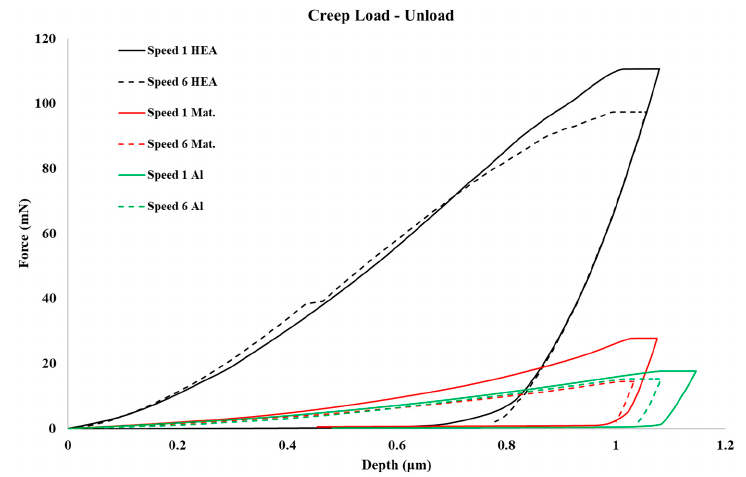
Figure 6. Creep indentation load—unload cycle curves for pure Al, matrix, and HEA reinforcement.